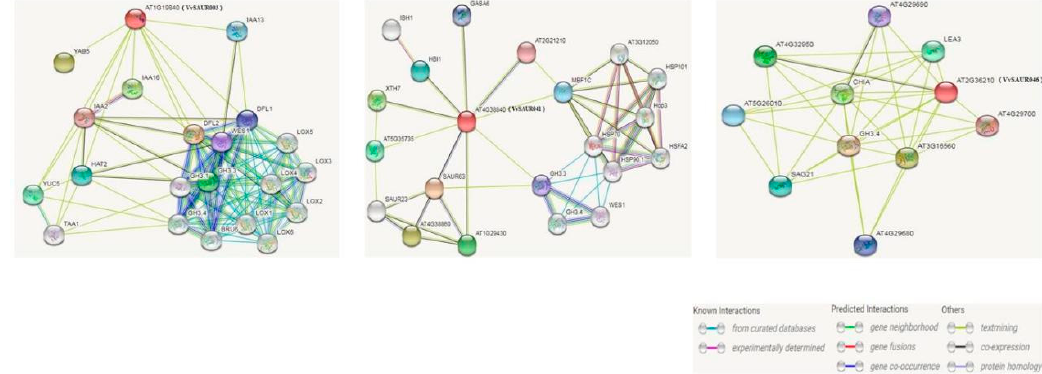
Figure 6. Interaction network analysis for VvSAUR003 , VvSAUR041 and VvSAUR046 . Note: The predicted results are based on the orthologous gene in Arabidopsis . VvSAUR genes are shown in parentheses.